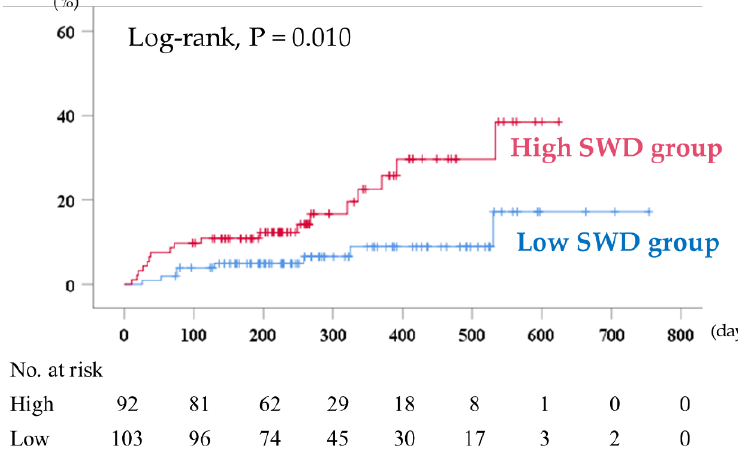
Figure 3. Kaplan–Meier analysis for cardiac event rates stratified by SWD levels. SWD indicates shear wave dispersion. Table 2. Subgroup analysis for predicting cardiac events (26 events / n = 195): the impact of high SWD (vs. low